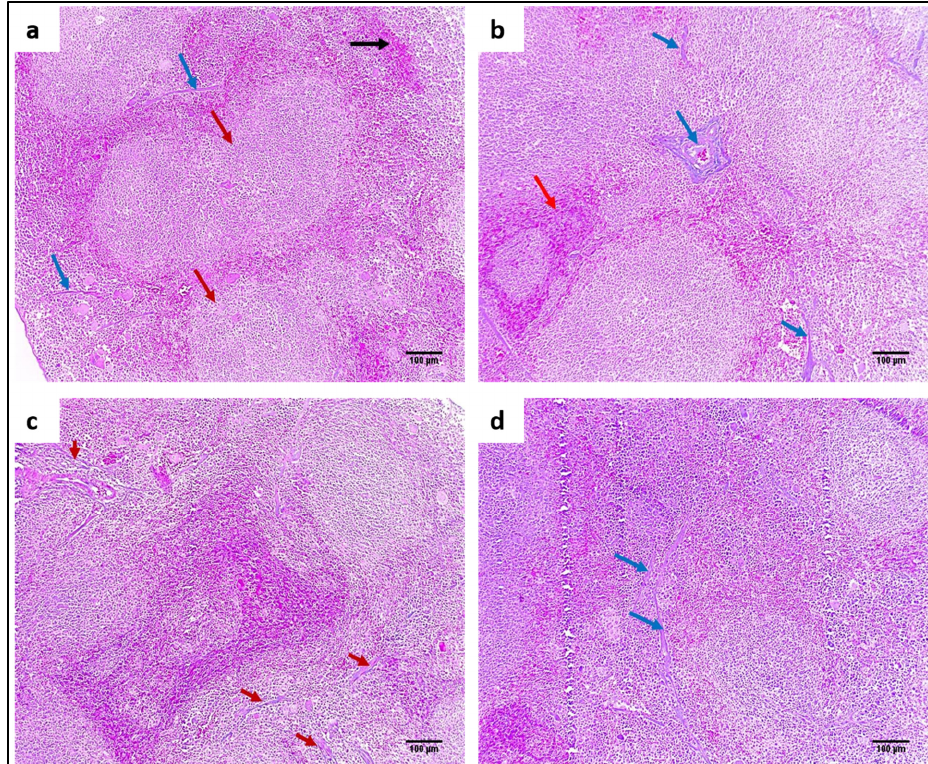
Figure 11. Masson’s trichrome stained spleen sections of ( a ) normal spleen showing splenic parenchyma formed of white (red arrows) and red pulps (black arrow). The stroma is represented by slight amounts of blue-stained collagen fibers (blue arrows) (×100). ( b ) Group I showed an area of congestion (red arrow) with multiple areas of blue-stained collagen fibres (blue arrows) (×100). ( c ) Group II showed a mild reduction of collagen fibres with remaining streaks of blue-stained collagen fibres (red arrows) (×100). ( d ) Group III showed a marked reduction of collagen fibres, and only the focal amount could be detected (blue arrows) (×100).